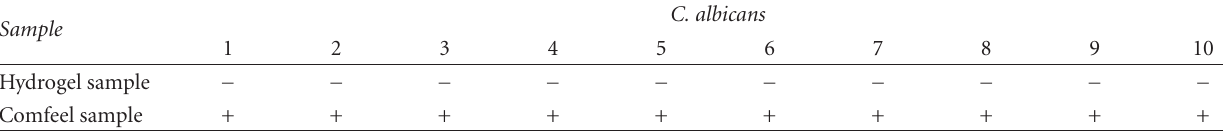
Table 1: Antifungal analysis